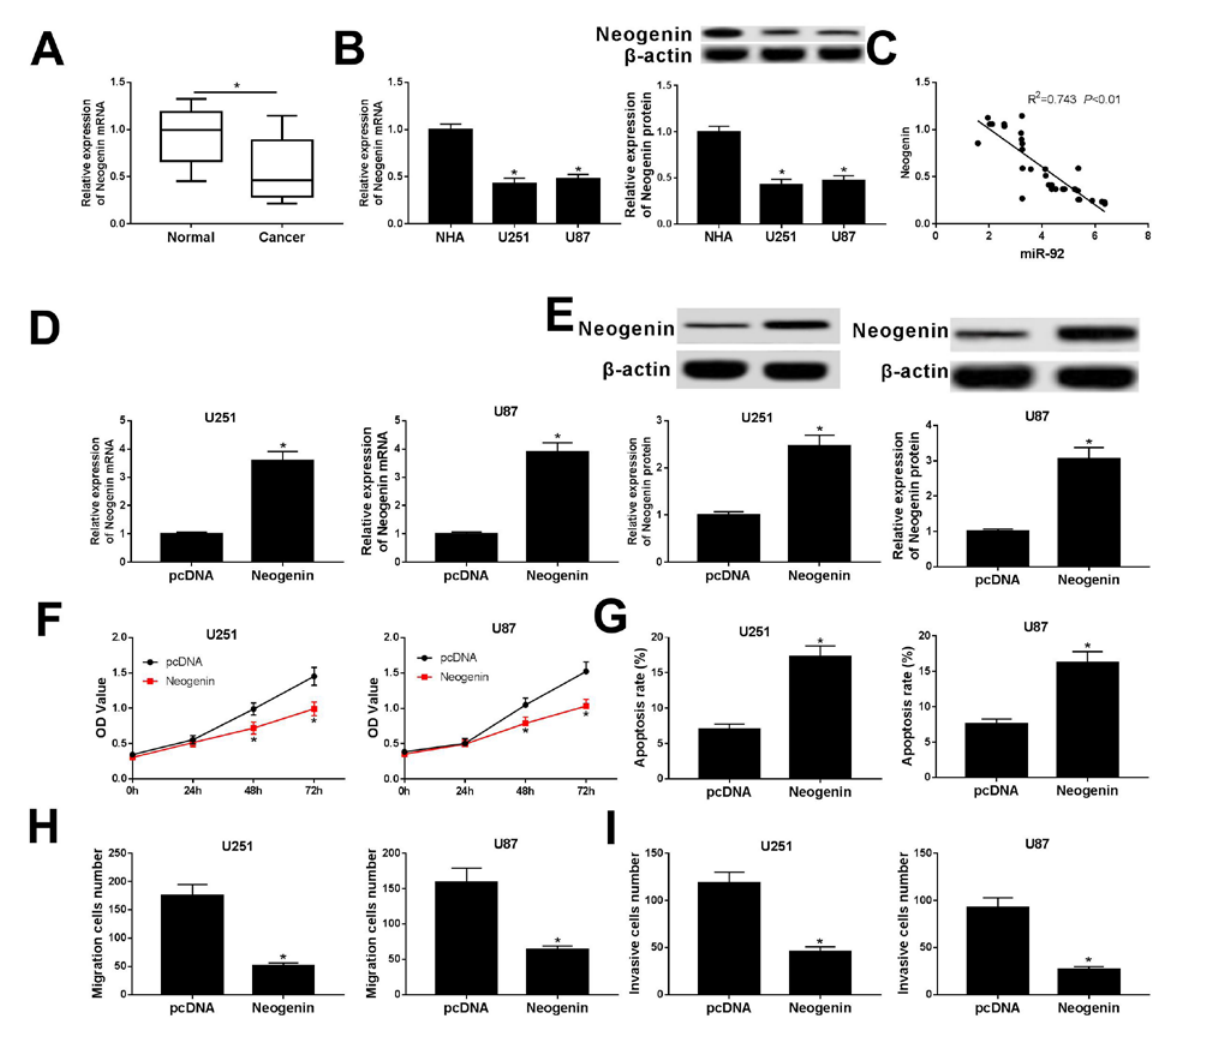
Figure 4: Neogenin modulated the proliferation, migration, invasion and apoptosis of glioma cells. (A and B) Expression level of Neoge- nin mRNA and protein was measured in glioma tissues and cell lines U251 and U87 by qRT-PCR and western blot assay, respectively. (C) Spearman’s rank correlation analysis testified the correlation between neogenin and miR-92 (R2=0.743, P< 0.01). (D-I) U251 and U87 cells were transfected with pcDNA-neogenin (Neogenin) or its empty vectors (pcDNA). (D and E) The neogenin mRNA and protein expression levels were evaluated by qRT-PCR and western-blot assay, respectively. (F) The cell proliferation ability was evaluated by MTT assay after transfec- tion for different times (24 h, 48 h and 72 h). (G) Glioma cell apoptosis rate was detected after transfection for 24 h by flow cytometry. (H and I) The migration and invasion abilities of U251 and U87 cells were performed after transfection for 24 h by transwell assay. *P <